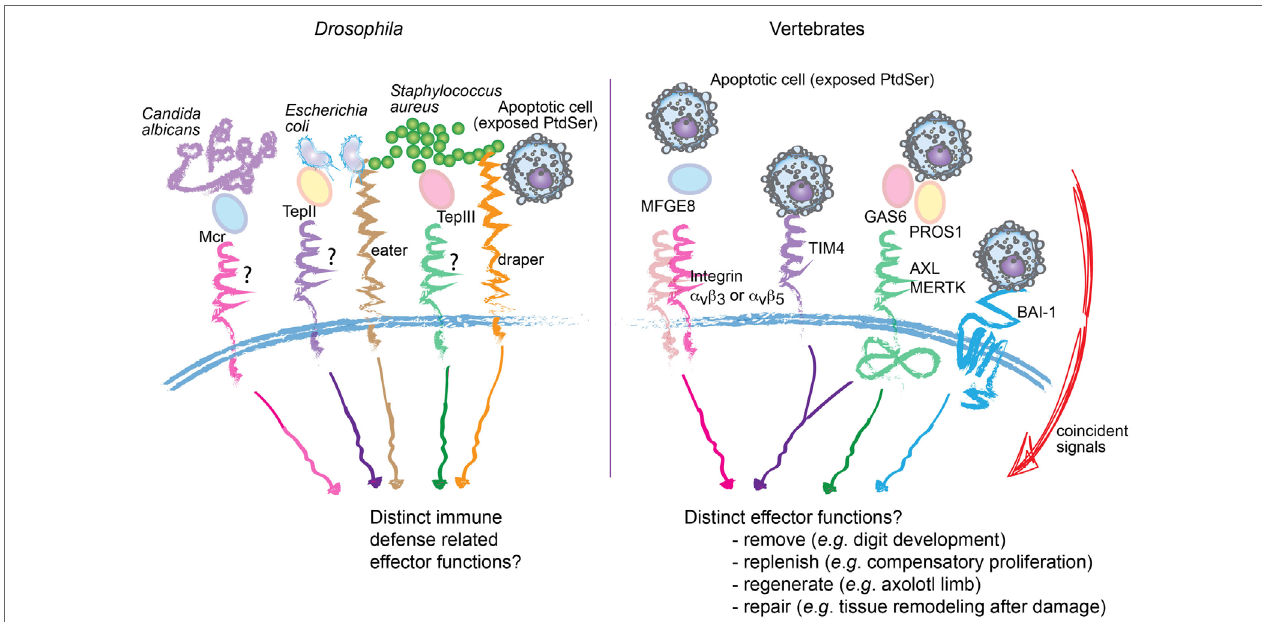
FiGURe 2 | Proposed specificity, rather than redundancy, in apoptotic cell recognition and engulfment. Comparative representation of molecular mediators involved in the recognition and engulfment of bacteria or apoptotic cells by phagocytes, in Drosophila (left) and vertebrates (right). In Drosophila , specific bacteria can be opsonized through secreted Mcr, Tep II, or Tep III before engulfment by hemocytes. Similarly, multiple phagocytic receptors in vertebrates, including integrins α v β 3 , α v β 5 and the receptor tyrosine kinases AXL and MERTK (right) also require “opsonization” of the apoptotic cargo. This raises the possibility of selective disposal and tailored effector functions. Consistent with this proposition, in vertebrates, not only are the number of phagocytic receptors and ligands expanded but also their engagement is integrated with specific signals from the